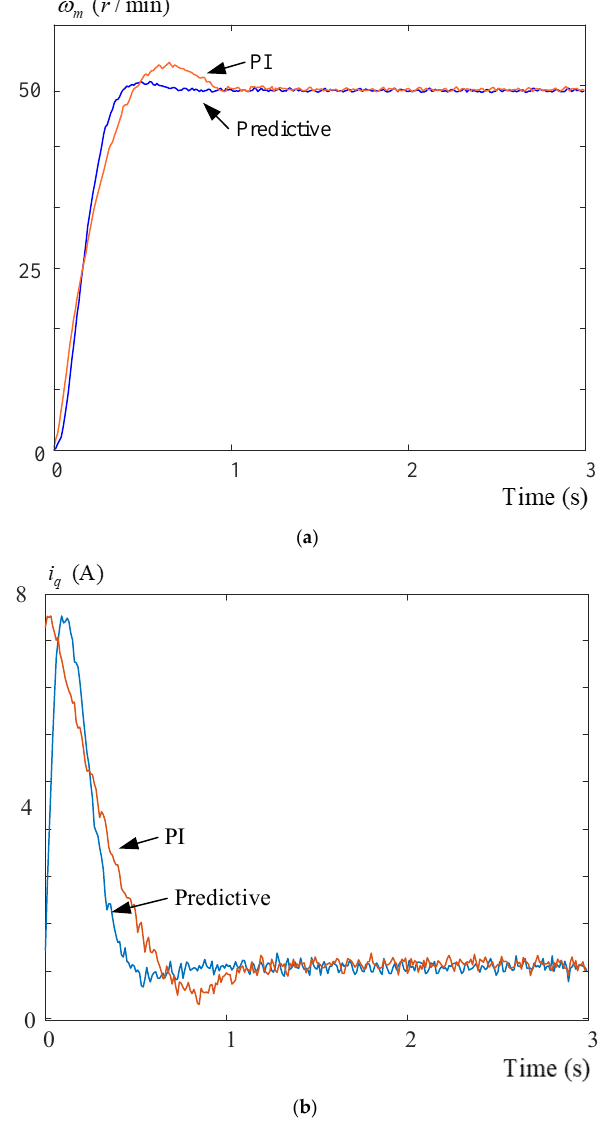
Figure 24. Measured responses with di ff erent controllers. ( a ) speeds, ( b ) q-axis currents.